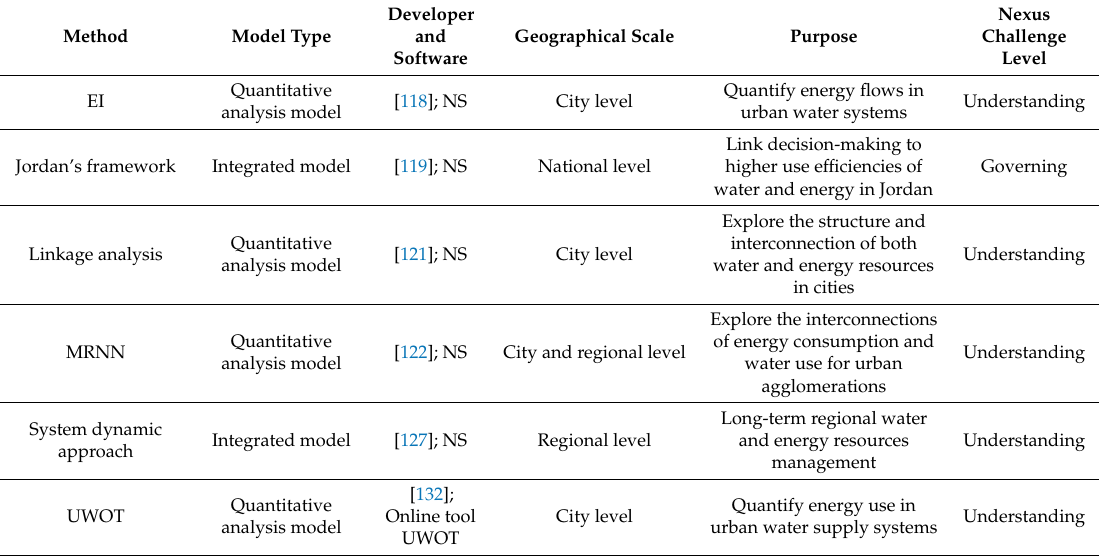
Table 1. Partial characteristics of the six methods in terms of the water–energy nexus (WEN) binding